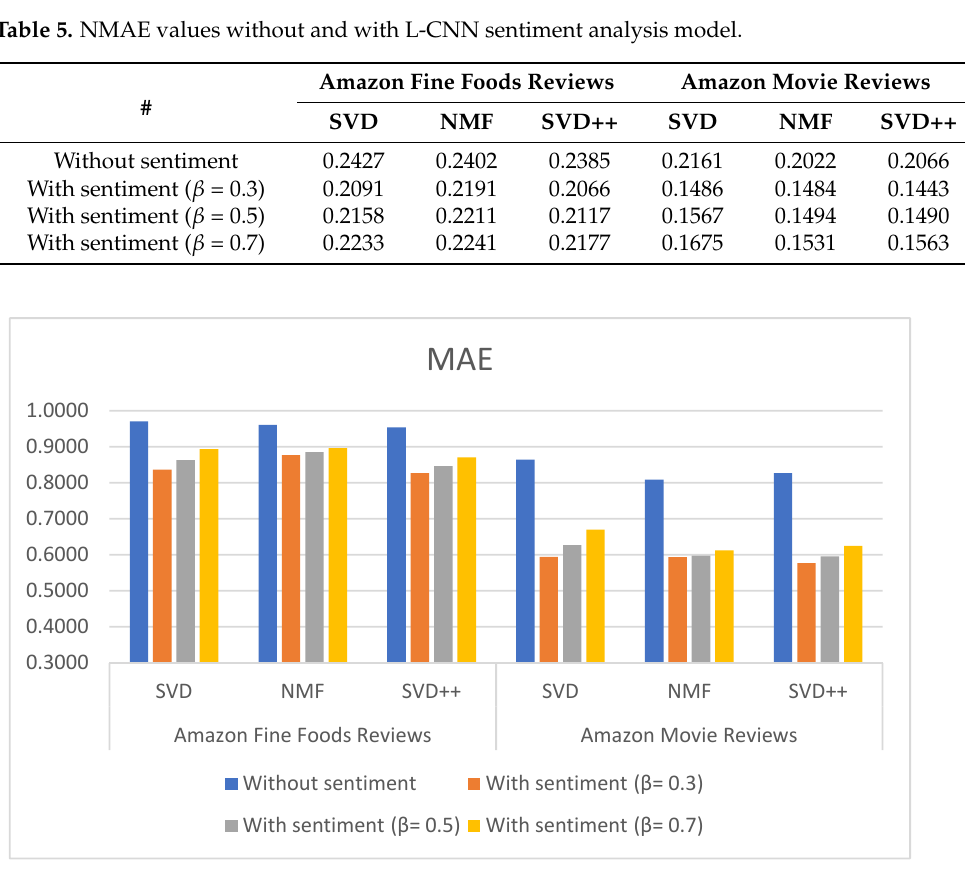
Figure 5. Sentiment performance of hybrid deep-learning models using BERT.